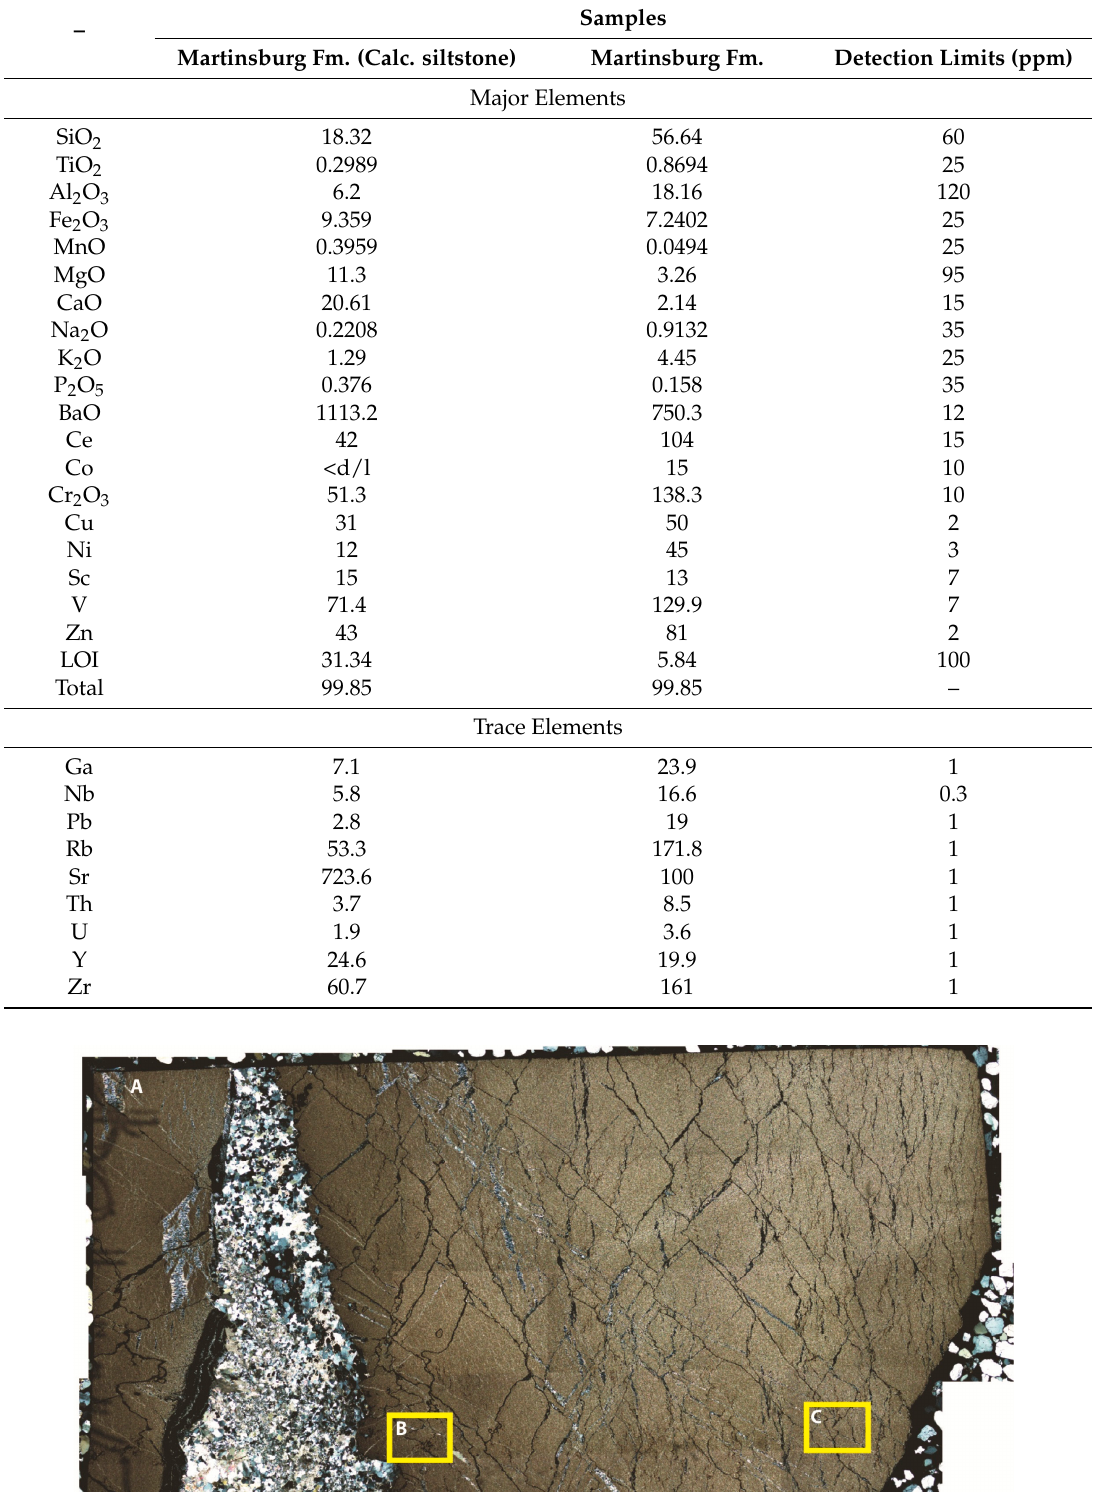
Table 3. Whole-rock geochemistry (XRF).